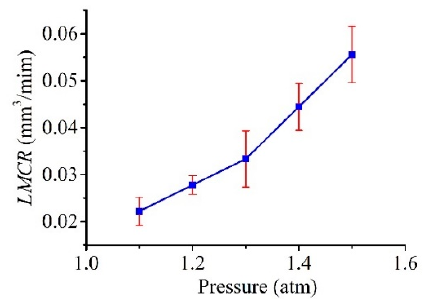
Figure 15. E ff ect of pressure P 1 on the liquid-metal consumption rate Figure 15. Effect of pressure P 1 on the liquid-metal consumption rate (LMCR).